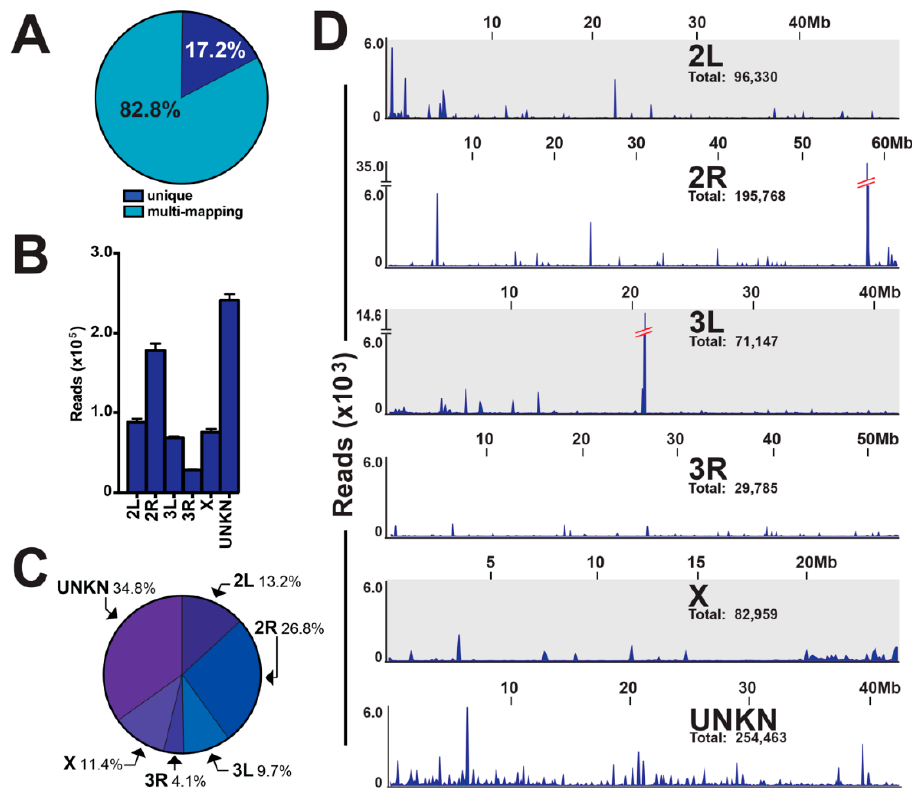
Figure 4. Genome-wide mapping properties of piRNAs. ( A ) Percentage of piRNA sequences with unique or multi-mapping properties. ( B ) Read intensity and ( C ) chromosomal contribution across chromosomes for unique mapping piRNAs, with the values graphed as average +/ − SEM from three biological replicates. ( D ) Genomic loci map of unique mapping piRNAs across chromosomes, with notable 58 Mb loci on chromosome 2R and 21 Mb loci on chromosome 3L accounting for approximately 20% of unique mapping piRNAs.